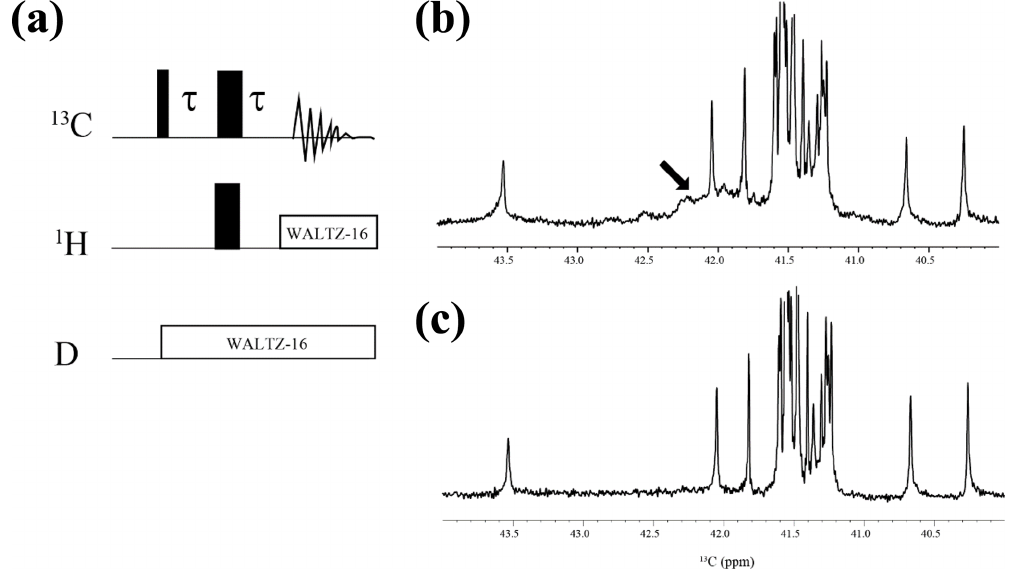
Figure A2. { 1 H, 2 D}-1D 13 C NMR spectra for the SNase variant selectively labeled with [ ε - 13 C; ε , ε -D 2 ]-Lys. The 125.7MHz 13 C NMR spectra were measured at 25 ◦ C on a Bruker Avance 500 spectrometer equipped with a 13 C-observing DCH cryogenic probe. The broad background signals observed in the spectrum (b) , indicated by a thick arrow, are due to the natural abundant 13 C atoms bound to proton(s), which are readily filtered out to give the spectrum (c) , using the pulse scheme shown in panel (a) . The narrow and wide bars in the scheme represent 90 and 180 ◦ rectangular pulses, respectively, and are applied along the x axis at τ = 1 . 7ms, which corresponds to 1 / 4 1 J CH . The SNase variant was dissolved in 100% D 2 O buffer, containing 20mM sodium phosphate and 100mM potassium chloride at pH 8.0. 13 C chemical shifts are referenced to